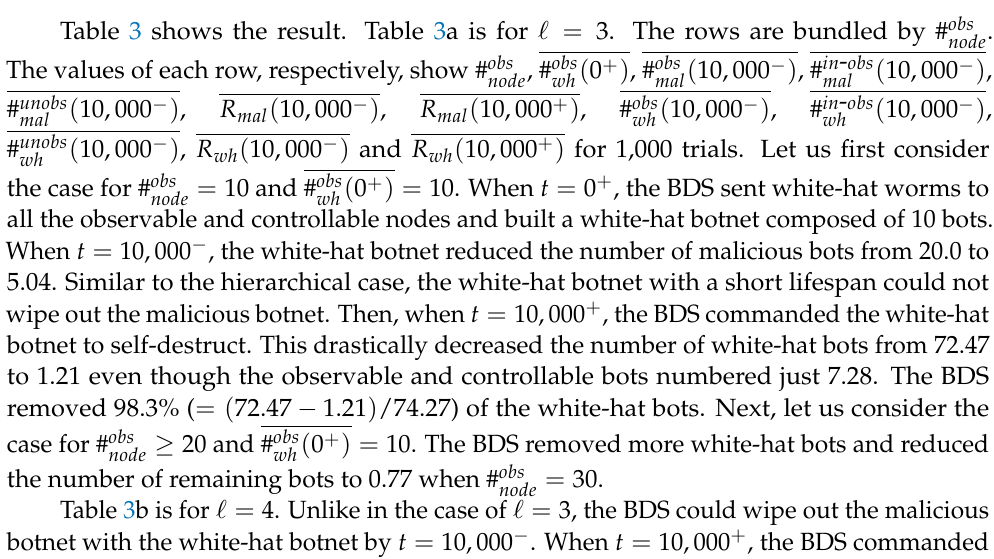
Figure 11. A state transition of the BDS for an IoT network with randomly determined observability and controllability. ( a ) State at t = 0 + . The BDS sent white-hat worms to 10 of 30 observable nodes in order to disinfect 20 malicious bots; ( b ) State at t = 10,000 − . The BDS will command self-destruction to the white-hat botnet according to the Withdrawal